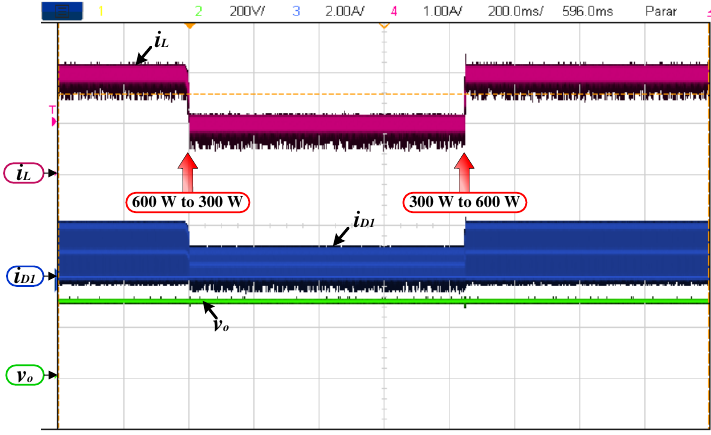
Figure 12. v o (200 V/div); i D